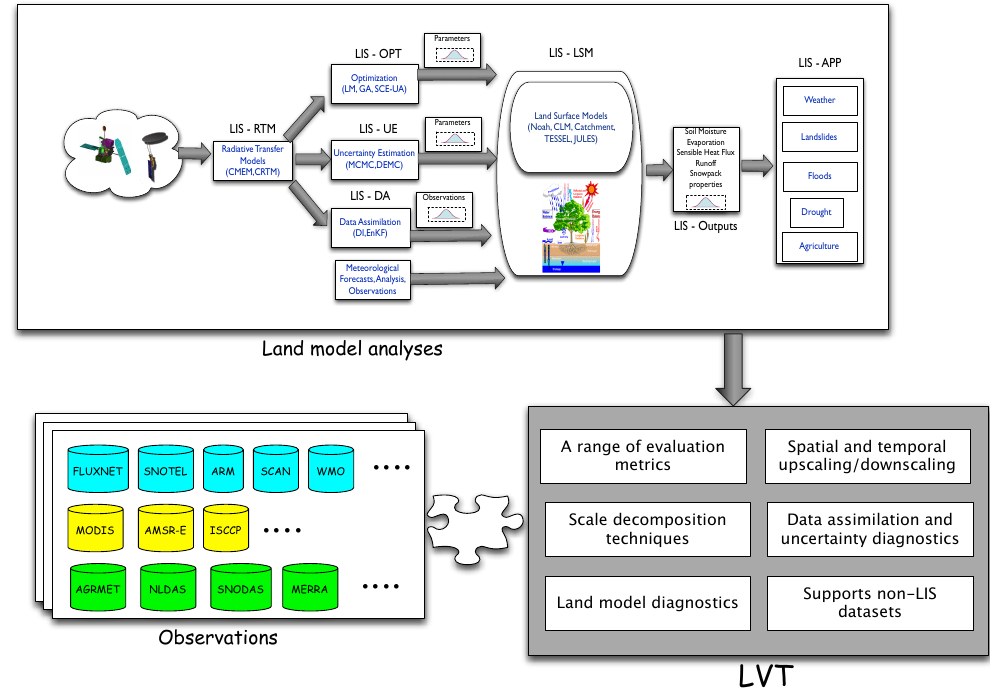
Fig. 1. Schematic of the Land surface Verification Toolkit and the association with the Land Information System (LIS). LVT supports the analysis of outputs from various LIS subsystems. LIS-DA represents the data assimilation subsystem, LIS-RTM represents the radiative transfer models within LIS, LIS-OPT represents the optimization subsystem, LIS-UE represents the uncertainty estimation subsystem, LIS-LSM represents the land surface models, and LIS-APP represents the various application models within LIS.